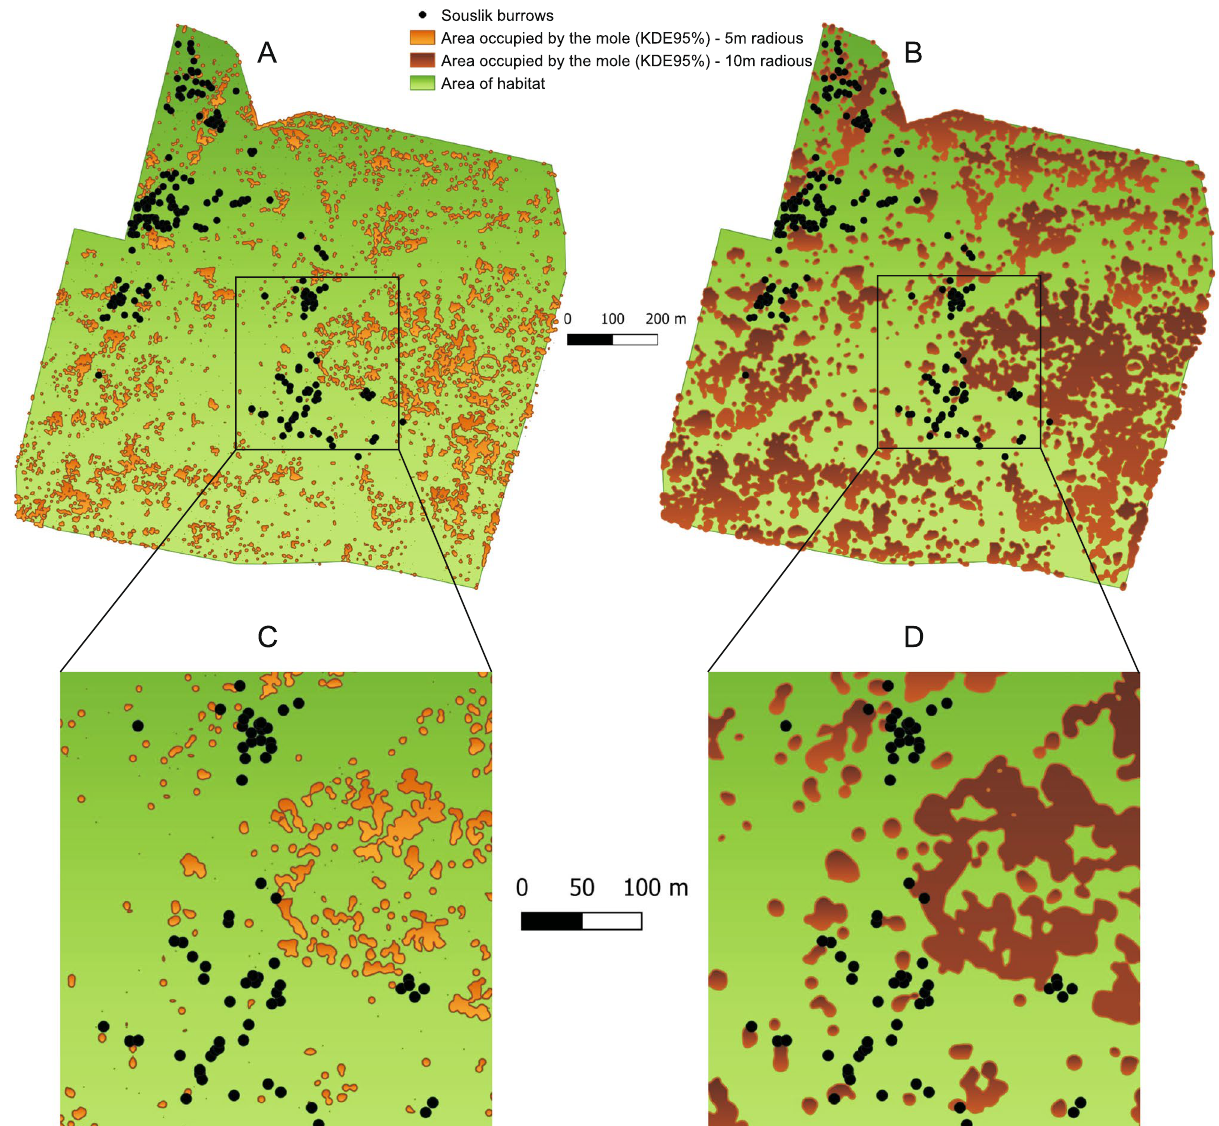
Figure 8. Location of 228 souslik burrows in 2019 and areas occupied by the mole designated on the basis of a 5 m radius for the 95% kernel ( A ) and a 10 m radius for the 95% kernel ( B ). For a more precise visualization, the enlarged central parts of the area are shown ( C , D ). The locations of sousliks’ burrows were determined in the field studies, and the area occupied by the mole was determined by the analysis of aerial images. There is a clear spatial separation of these two species: the souslik burrows overlap with the area occupied by moles only in 0.9% of the cases in figure ( A ) and in 8.7% of the cases in figure ( B ). The figure was generated in Quantum GIS v.3.4.5 (https:// qgis. org) and CorelDRAW Standard 2020 (https:// www. corel. the population and the territoriality of individuals. It is regulated by odour signals and the social structure of the population 30,31 . Koshev 32 described aggressive reactions of free-ranging European sousliks to other vertebrate species that appeared near burrows: towards the reptile Lacerta trilineata , the bird Corvus frugilegus , and the mammal Mustela nivalis . Theoretically, the mole can get into the souslik’s burrow unintentionally when digging new tunnels. For souslik, the presence of moles in their nest burrow means a violation of its strictly defended territory and is probably a highly stressful episode. It can therefore be assumed that sousliks should choose places outside areas of frequent occurrence of other burrowing mammals to set up a nest burrow. It remains an open question whether avoidance of areas where the mole is often present may be important for the souslik during winter hibernation. Theoretically, the presence of moles in souslik burrows during hibernation may disturb this process and cause waking up and energy-consuming increases in metabolism, which may reduce winter survival. It is also unknown whether the mole can be a predator for the souslik during winter hibernation. Remains of rodent species were found in the digestive tracts of moles 33 ; therefore, at least theoretically, the mole may use such a food source. On the other hand, remains of vertebrates, including the remains of moles, were sometimes found in the stomachs of sousliks 18 . The relationship between the souslik and the mole may therefore